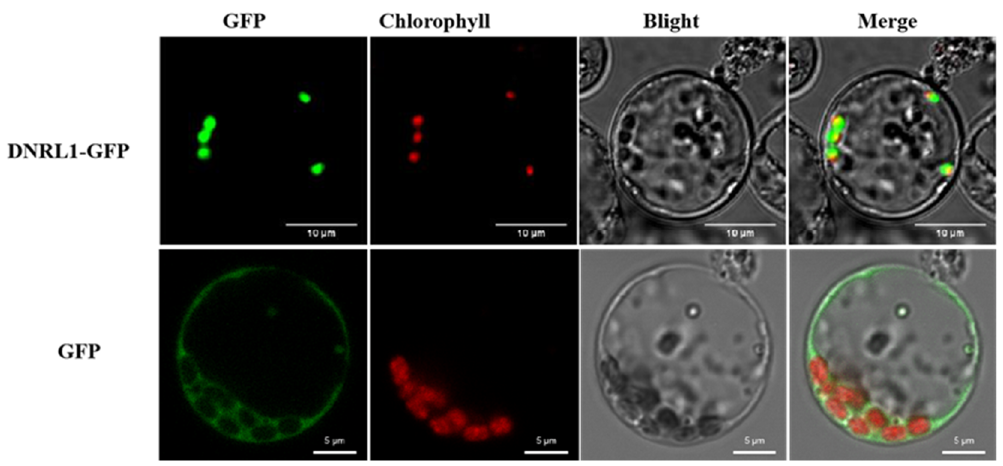
Figure 6. Subcellular location of DNRL1-GFP at chloroplasts. Subcellular location of DNRL1-GFP was performed using rice protoplasts. GFP, green fluorescence protein. For DNRL1-GFP, bar = 10 µ m; for GFP, bar = 5 μ m.